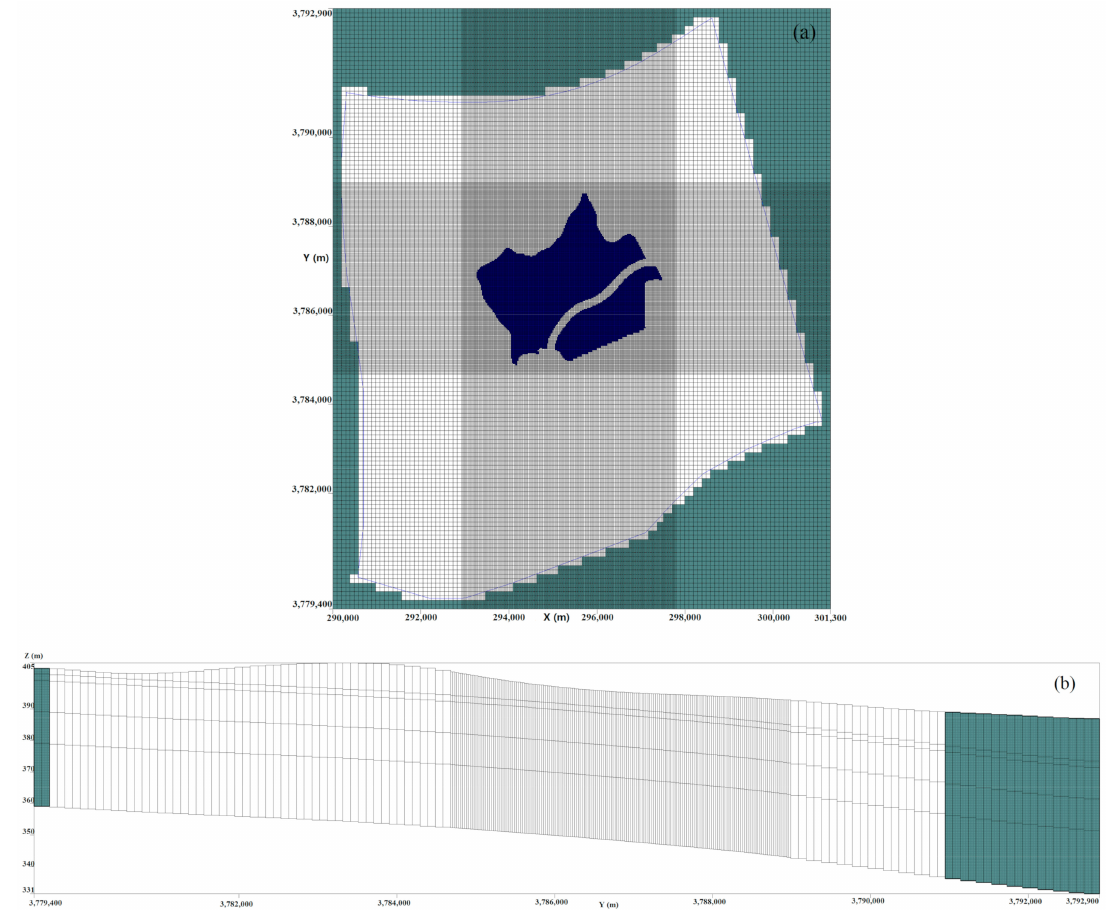
Figure 7. Model spatial discretization in ( a ) horizontal; ( b ) vertical.